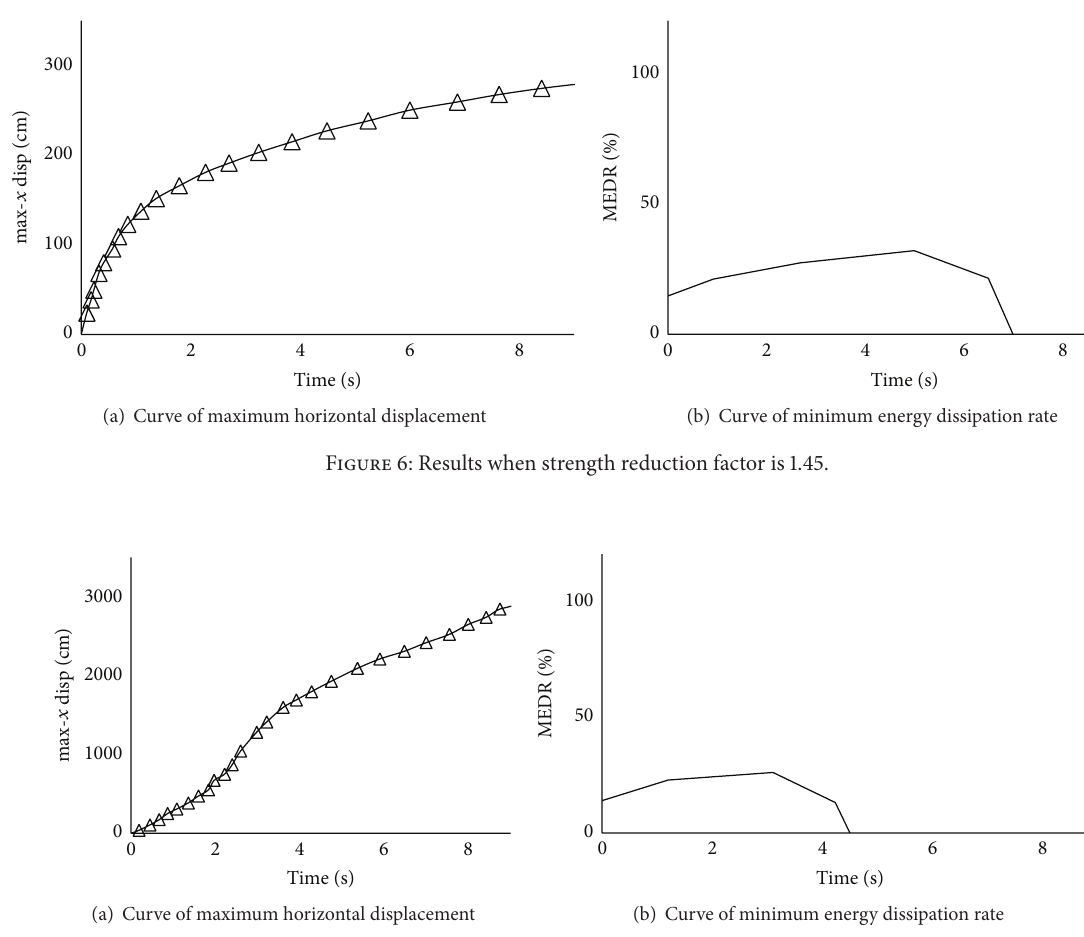
Figure 7: Results when strength reduction factor is